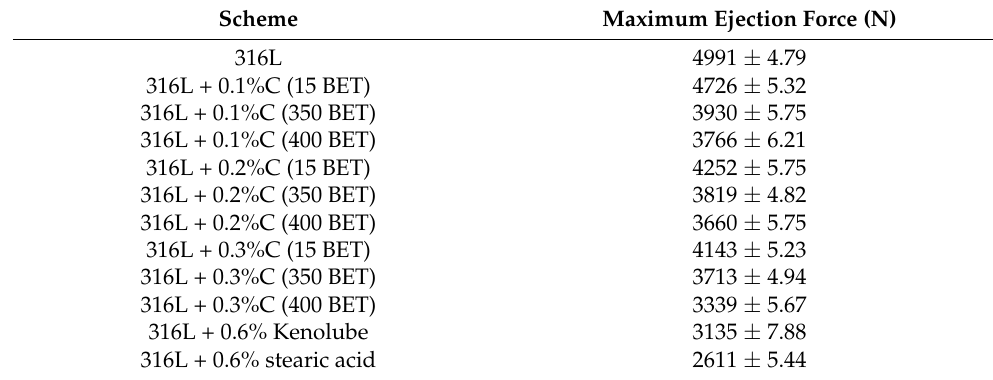
Table 4. Values of the maximum force while removing the compacts from the die depend on the percentage composition of mixtures.